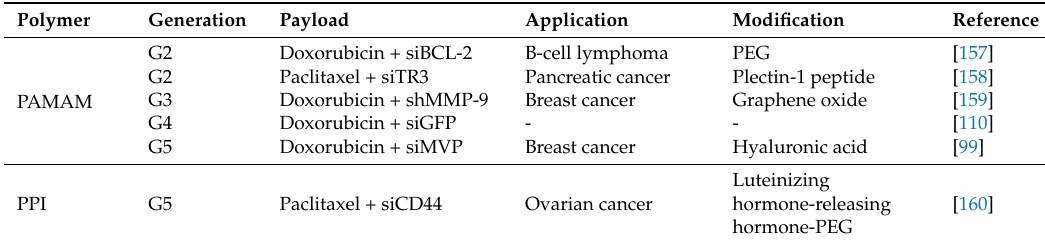
Table 4. Examples of dendrimer-based nanosystems as carriers of drug and nucleic acids simultaneous.